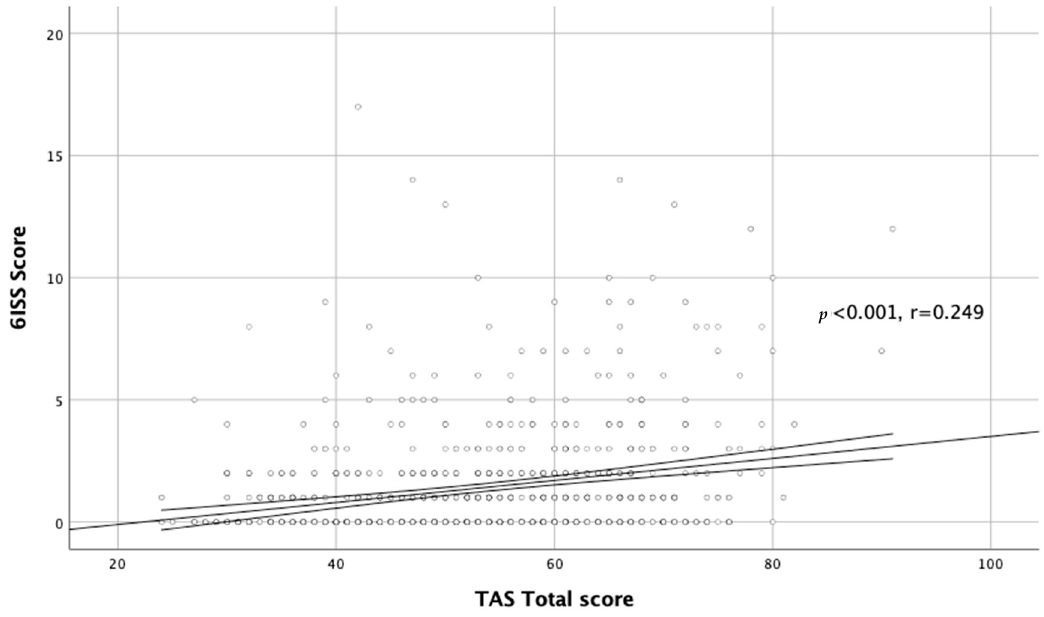
Figure 3. Correlation between TAS total score and DLQI total score.